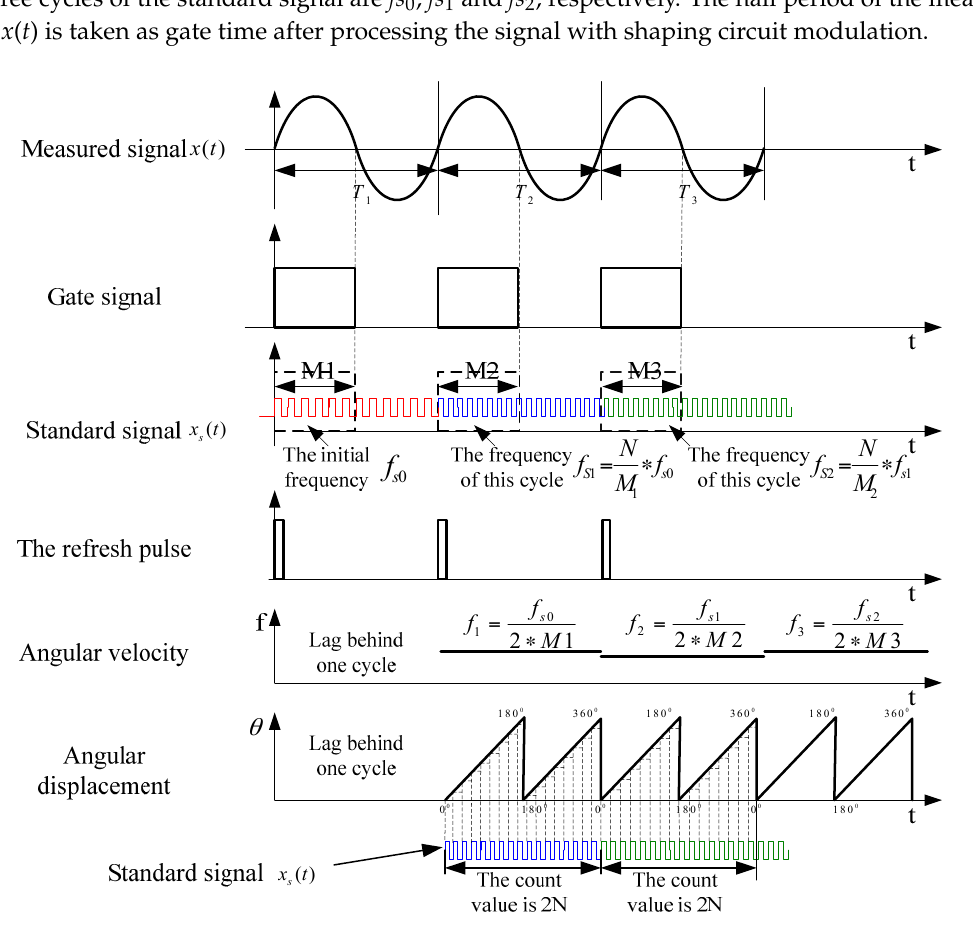
Figure 2. Schematic diagram of the self-adaptive frequency tracking measurement method.